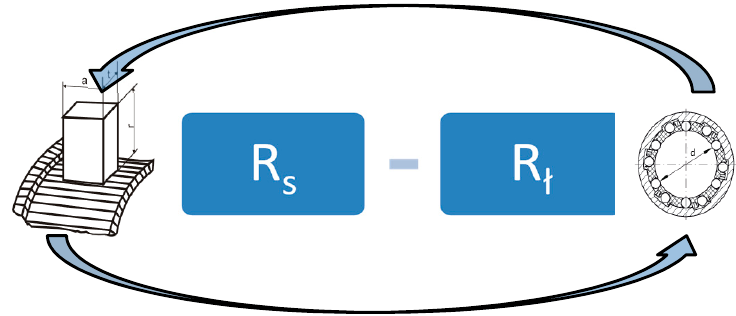
Figure 3. Reliable series-type structure for a starter-generator.